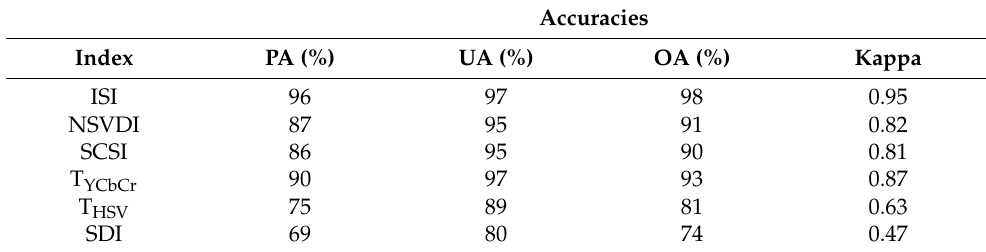
Table 4. Shadow extraction accuracy of the indexes in Site 2.